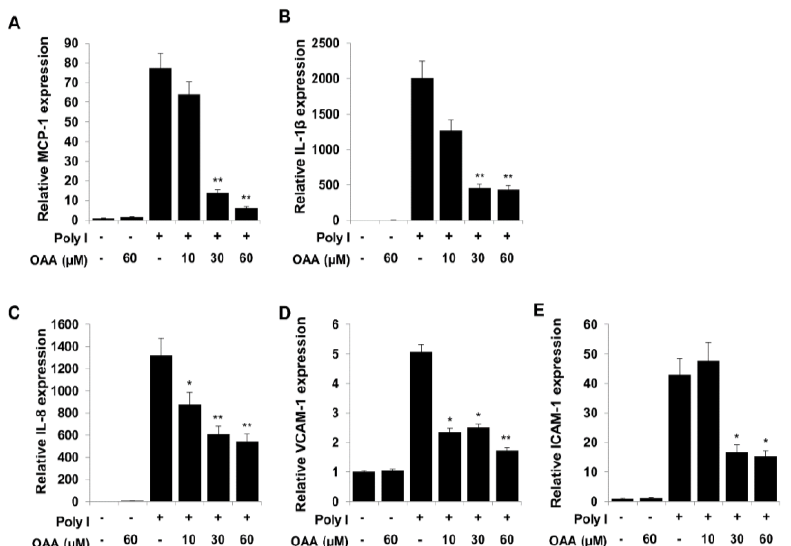
Figure 2. Cells were pretreated with OAA at the indicated concentrations for 1 h before treatment with poly(I) (50 µ g / mL) for 12 h, and then total RNA was isolated. The expression levels of inflammatory chemokines or cytokines such as MCP-1 ( A ), IL-1 β ( B ), IL-8, ( C ), VCAM-1 ( D ), and ICAM-1 ( E ) were analyzed by quantitative real-time PCR. Values are presented as ± SD of three individual experiments. * p < 0.05 and ** p < 0.01 compared with the Poly I-treated group.